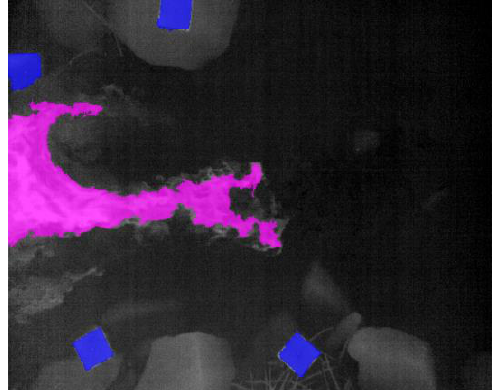
Figure 7. Interest Regions Extraction Results of 61 st Image: blue regions refer to control point area, while pink region represents hot water area.